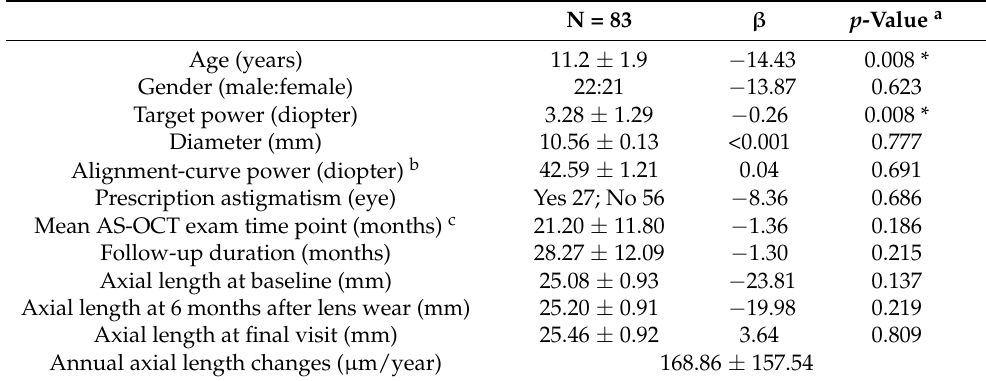
Table 1. Demographics and treatment data revealed that age and target power were both negatively associated with annual axial length changes.